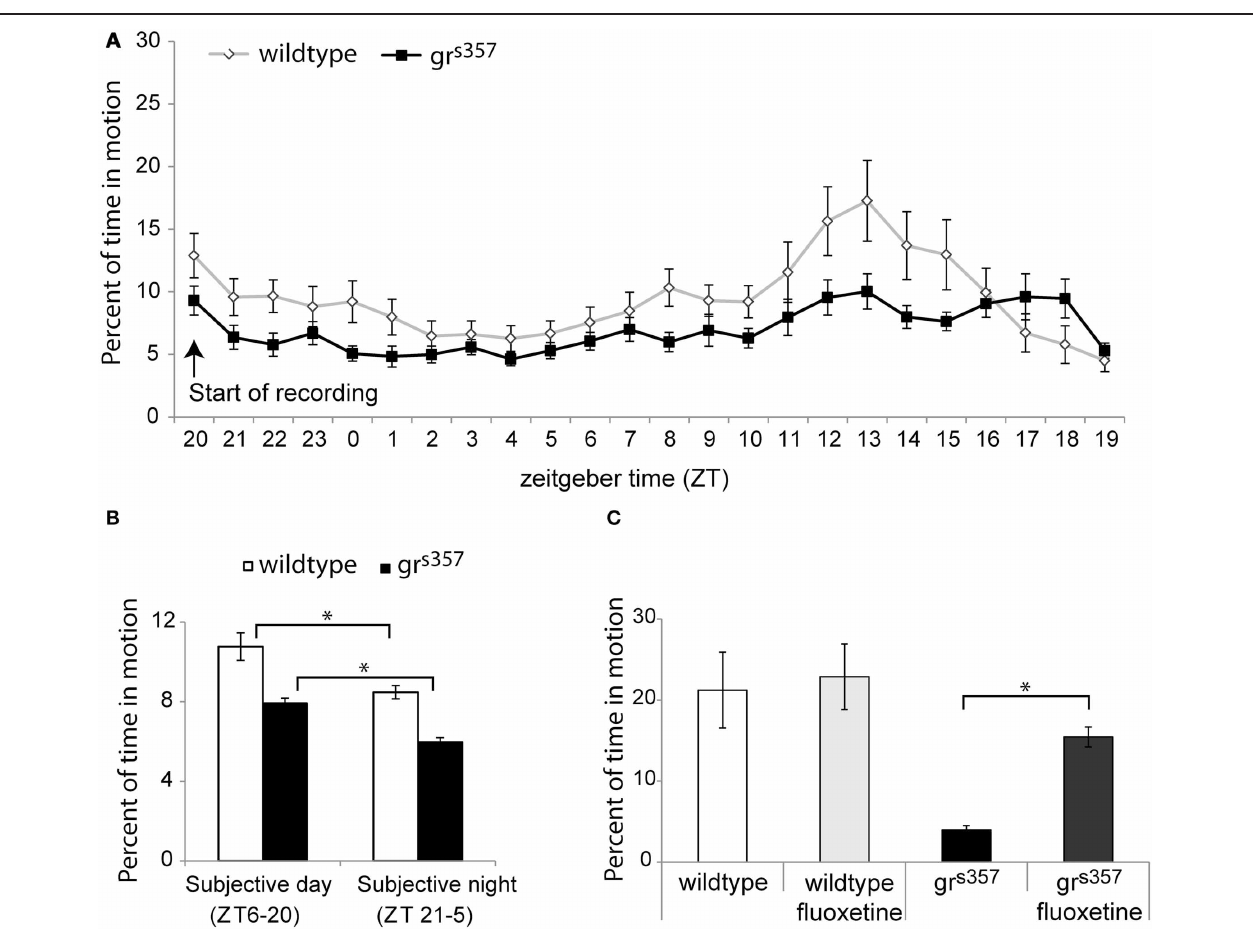
(B) Activity as a function of subjective light cycle phase. Both groups had significantly higher activity during the subjective light phase. (C)